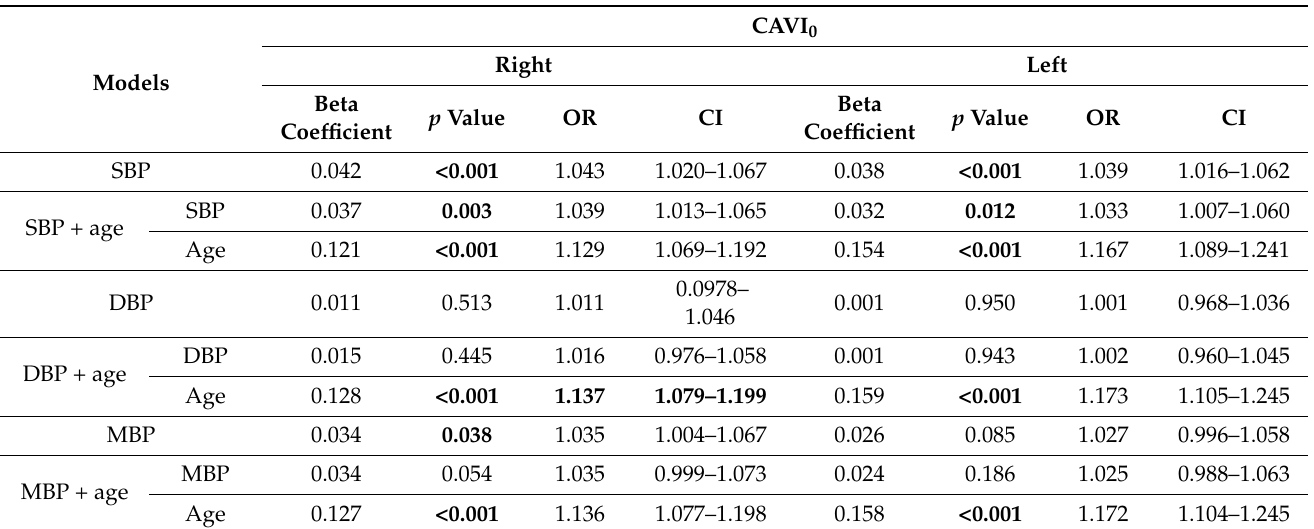
Table 7. Logistic regression models to assess the independency of the association between blood pressure indices and CAVI 0